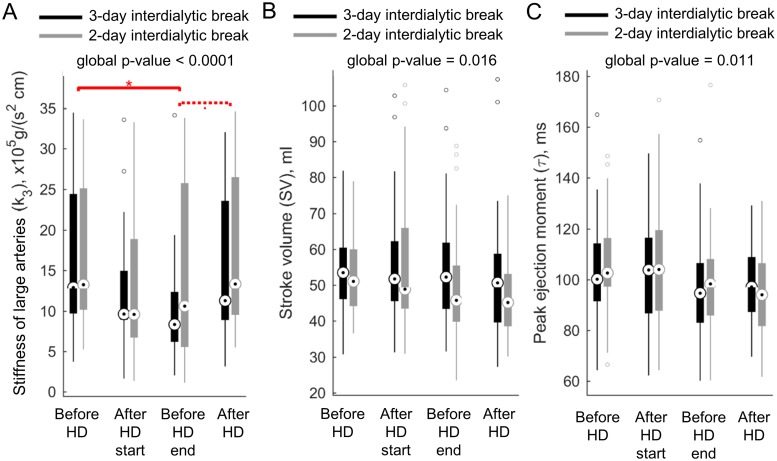
Effects of hemodialysis on the model-estimated parameters.Repeated measurements statistical testing revealed that hemodialysis affects the model-predicted stiffness of large arteries (A), stroke volume (B), and peak heart ejection moment (C). Each box represents the interquartile range with the circle within being the sample median. Hollow circles denote outliers, i.e. values that are more than 1.5 times the interquartile range away from the top or bottom of the box. Whiskers show the furthest observations when neglecting outliers. The global p-value from the Wittkowski test statistics is shown above each boxplot. Solid red line with an asterisk above indicates multiple-comparison p-value < 0.05 whereas dotted line shows borderline statistical significance, i.e. p-value < 0.1.